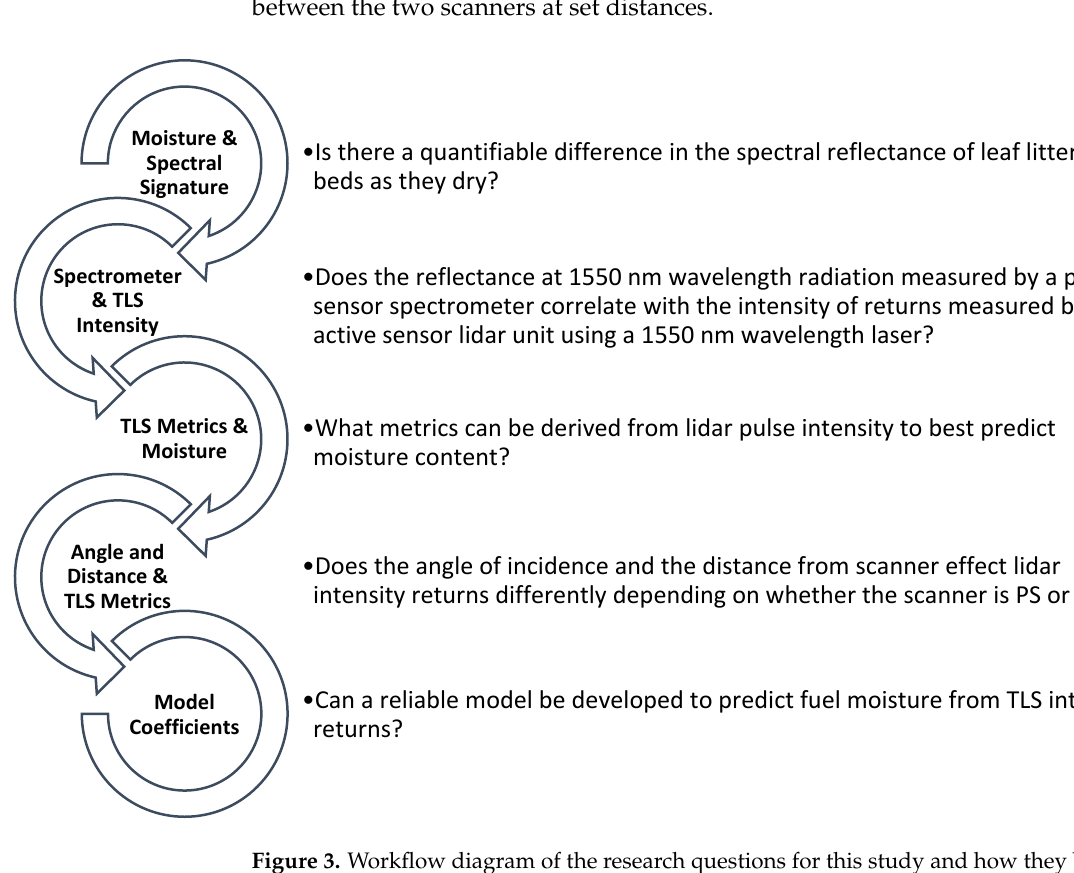
Figure 3. Workflow diagram of the research questions for this study and how they build upon each other to address the final goal of model development.